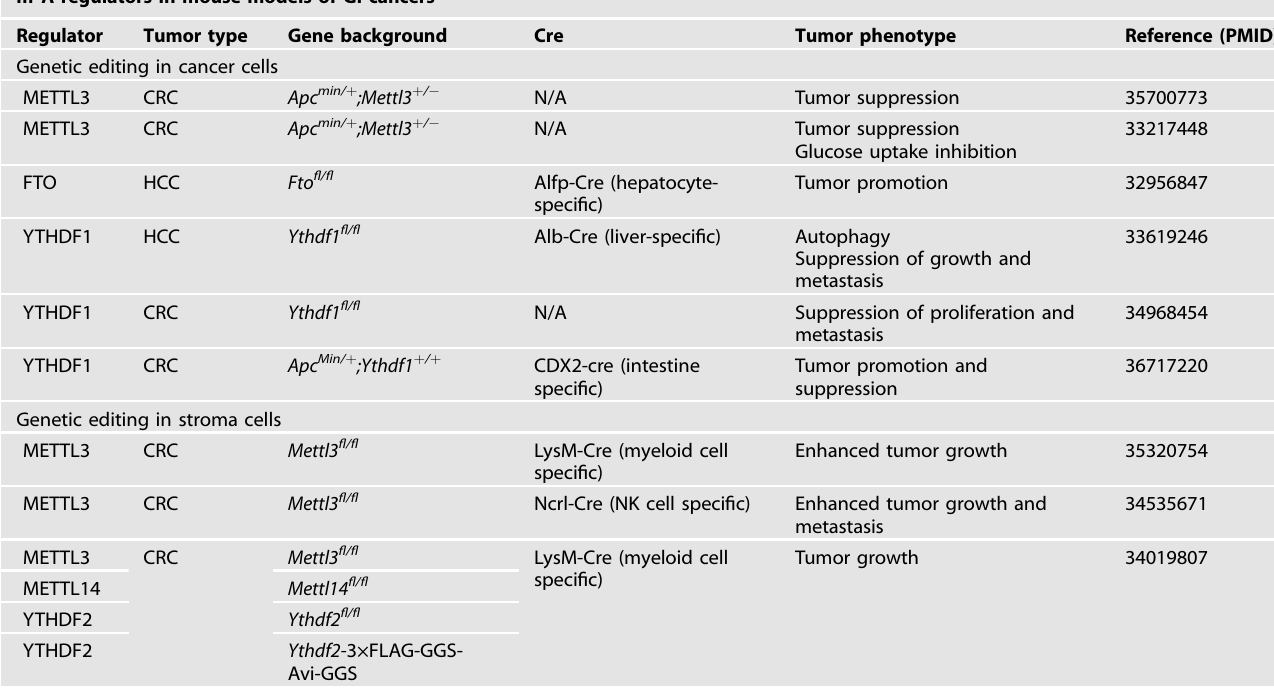
Table 3. The roles of m 6 A regulators in GI cancers as revealed using genetically engineered mouse models. m 6 A regulators in mouse models of GI